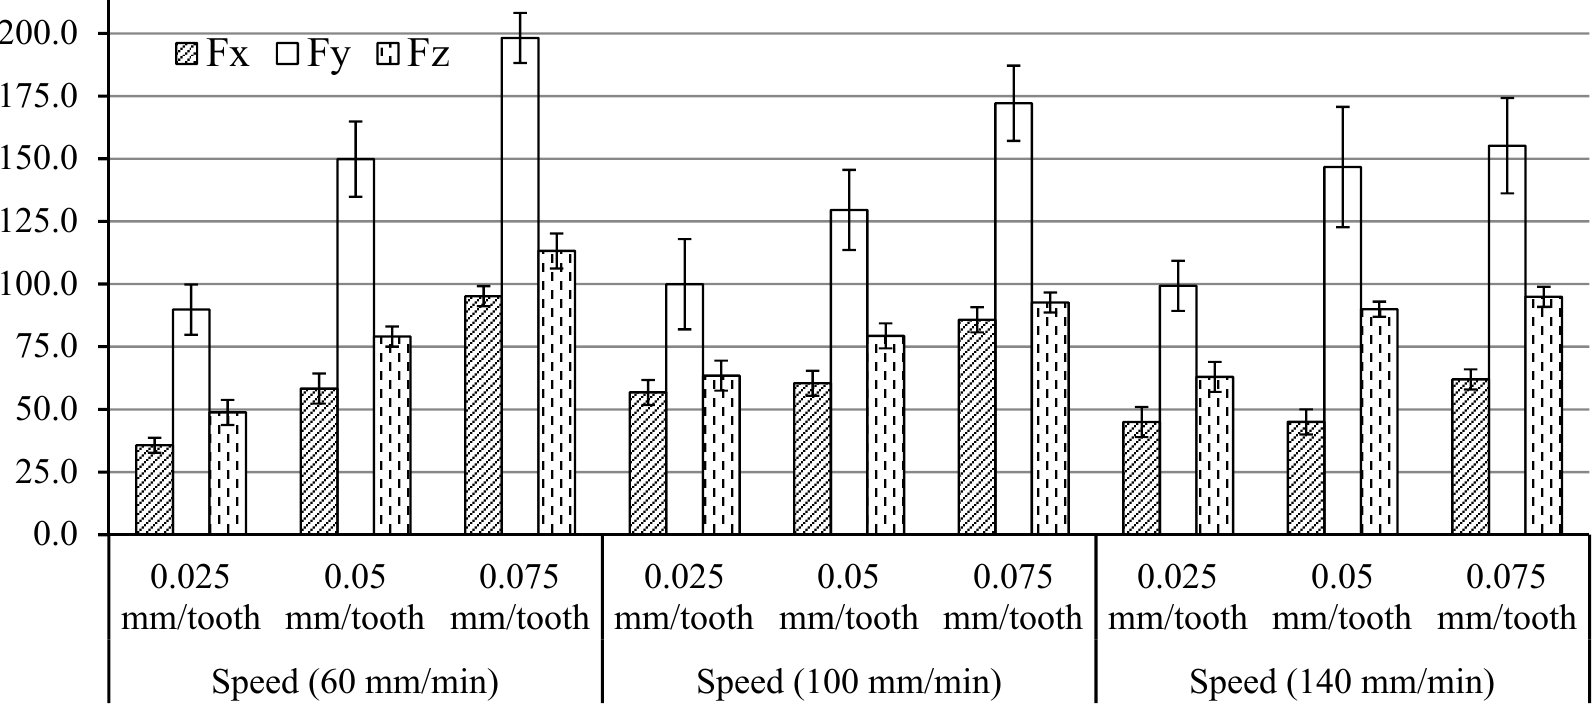
Figure 7. Machining forces in different conditions.